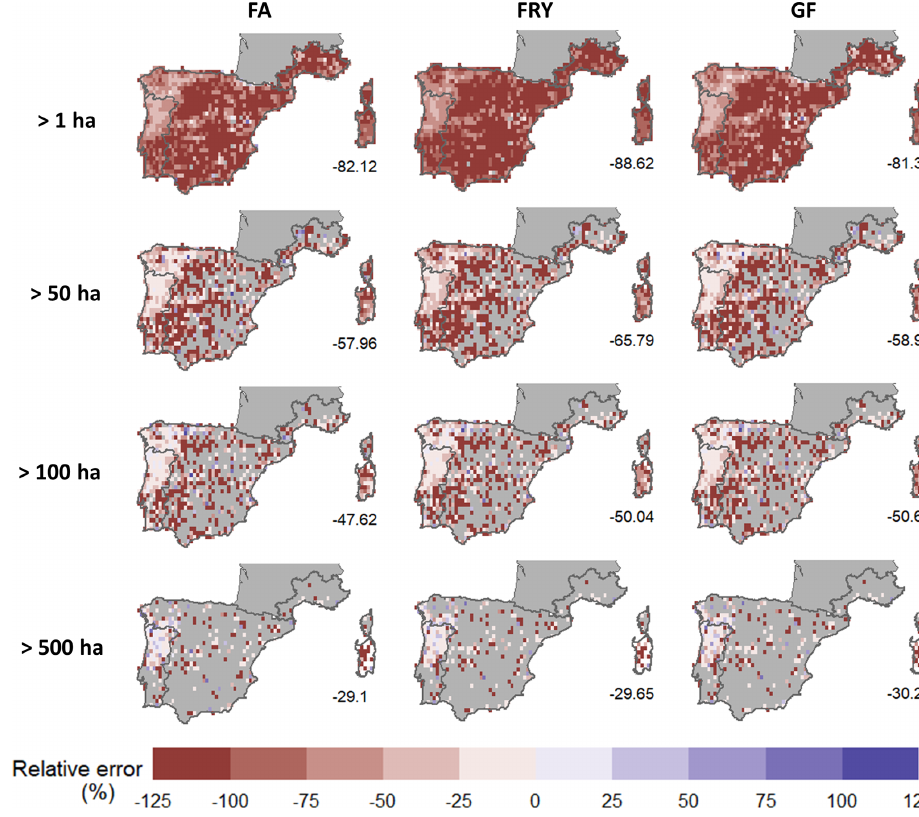
Figure 8. Same as Fig. 7 but for number of